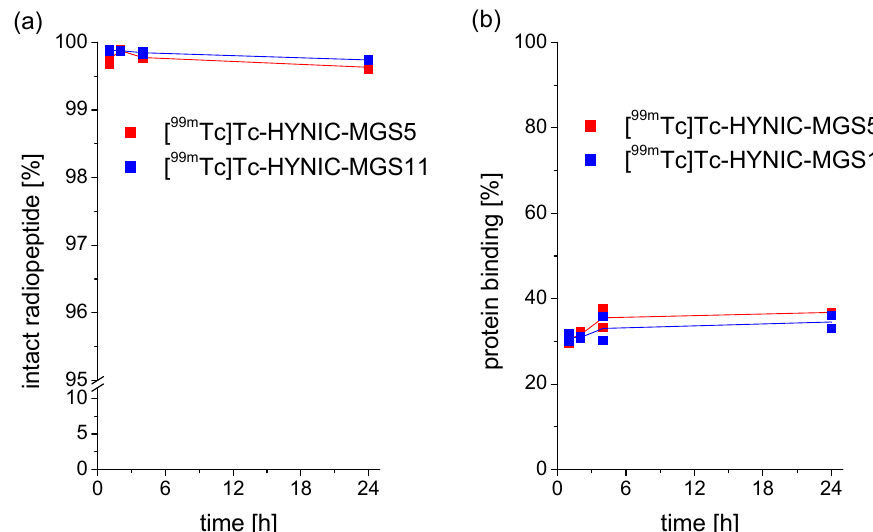
Figure 3. In vitro properties of [ 99m Tc]Tc ‐ HYNIC ‐ MGS5 (red) and [ 99m Tc]Tc ‐ HYNIC ‐ MGS11 (blue): ( a ) stability in human serum ( n = 2), ( b ) protein binding ( n = 2).